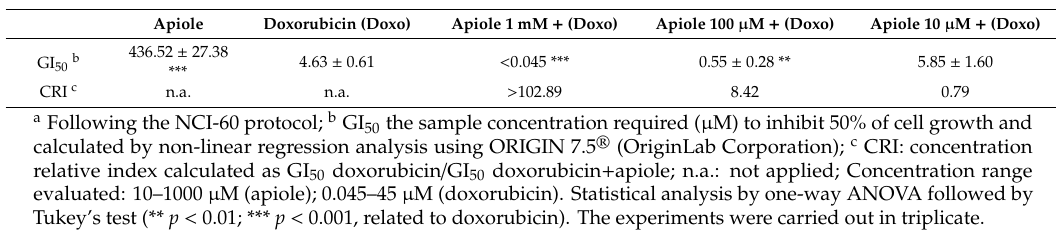
Figure 3. Isobolograms representing the synergistic interaction of the apiole with chemotherapeutic drugs doxorubicin ( A ) and vincristine ( B ) on NCI / ADR-RES cell line, after 48 h of incubation. Table 3. Antiproliferative activity a expressed as GI 50 b ( µ M) of apiole, doxorubicin, and their association against the multidrug-resistant ovarian adenocarcinoma cell line NCI / ADR-RES after 48 h